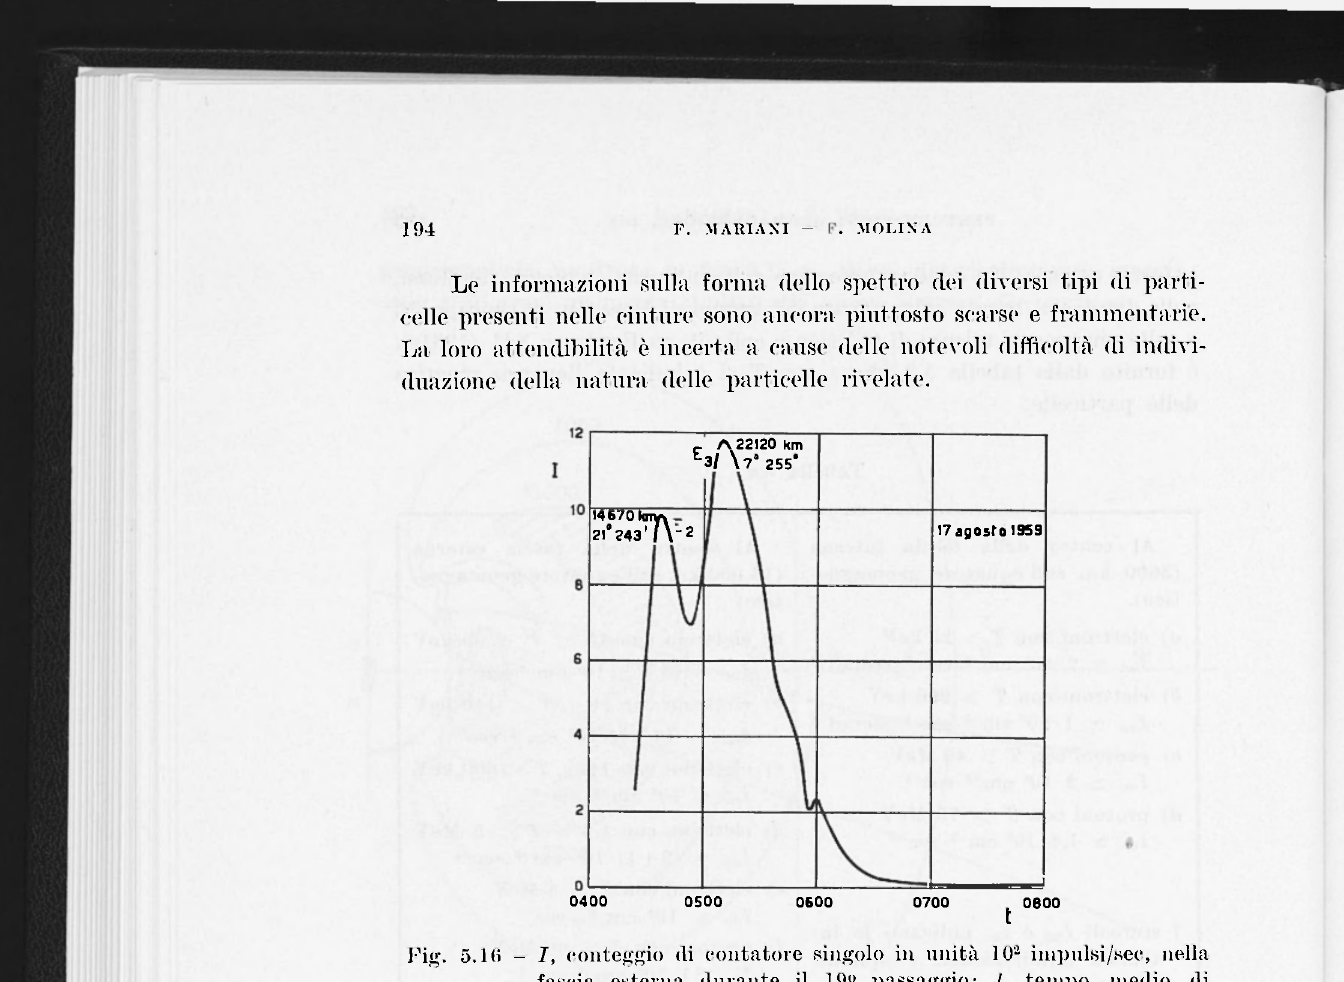
Fig. 5.1(1 - 7, conteggio di contatore singolo in unità IO 2 inipulsi/sec, nella fascia esterna durante il 19° passaggio; f, tempo medio di Greenwicli; sono indicate le distanze sul suolo dei due massimi E 2 , E 3 e le coordinate geografiche, latitudine e longitudine, alle quali essi furono riscontrati (secondo Fan, Meyere